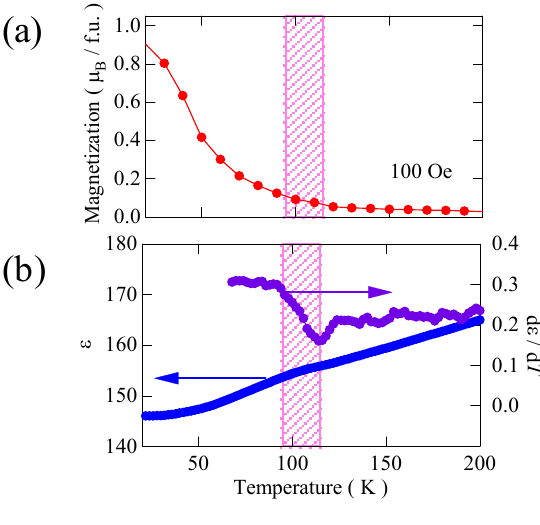
Figure 8. (a) Temperature dependence of magnetization of Bi substrate; (b) Temperature dependence of dielectric constant and the temperature SrTiO 3 derivative of the film. An anomaly in  near the ferromagnetic transition temperature (near 100 K indicated in pink) suggests some interplay between the ferromagnetic and ferroelectric